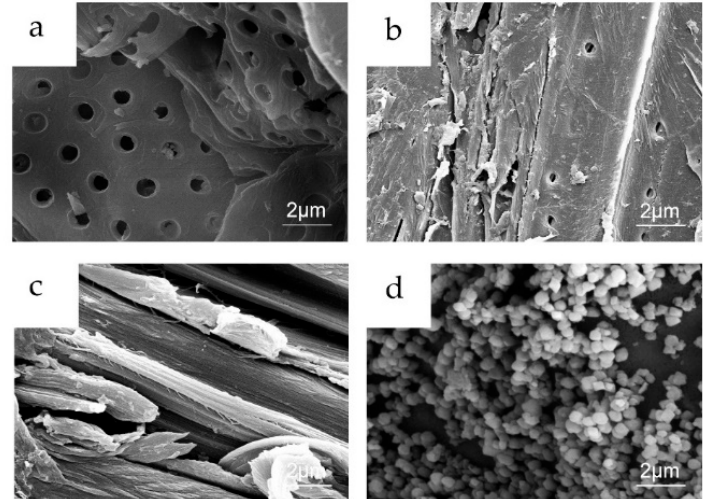
Figure 2. Scanning electron microscopy (SEM) images of chitosan / sodium phytate / nano-Fe 3 O 4 composite coatings on wood surfaces obtained by stepwise assembly: ( a ) original wood, ( b ) chitosan- coated wood, ( c ) sodium phytate-chitosan-coated wood and ( d ) nano-Fe 3 O 4 -sodium phytate-chitosan- coated wood.